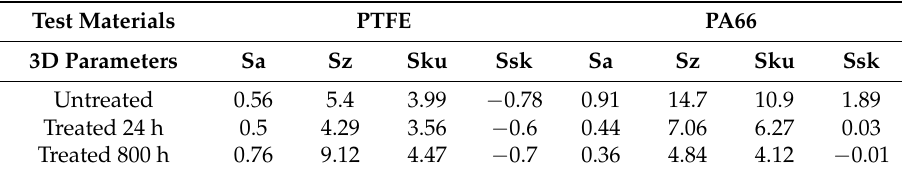
Table 5. 3D surface characteristics of PTFE and